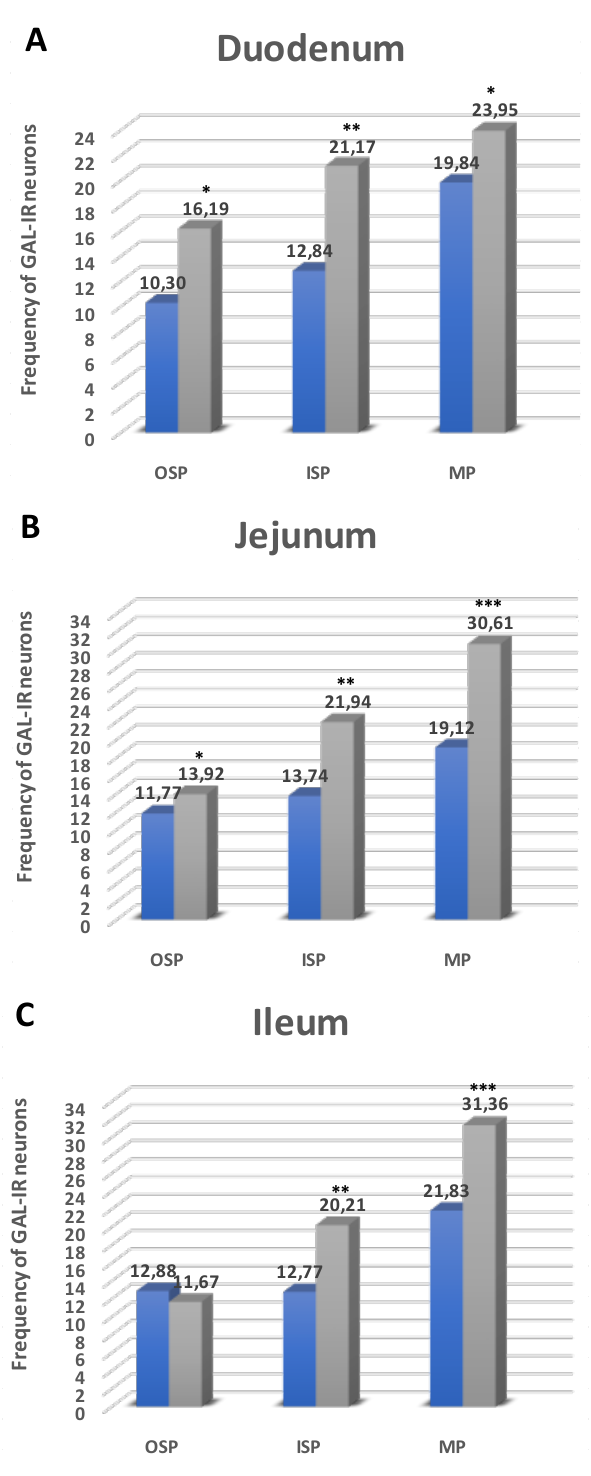
Figure 3. Schematic diagram of the numbers of perikarya immunoreactive to galanin (GAL) ( A–C ) of the control (blue bars) and experimental group (grey bars) in the particular parts of the small intestine. OSP – outer submucosal plexus, ISP – inner submucosal plexus, MP – myenteric plexus. * p < 0.05, ** p < 0.01, *** p < 0.001 – indicate differences between all groups for the same neuronal populations.